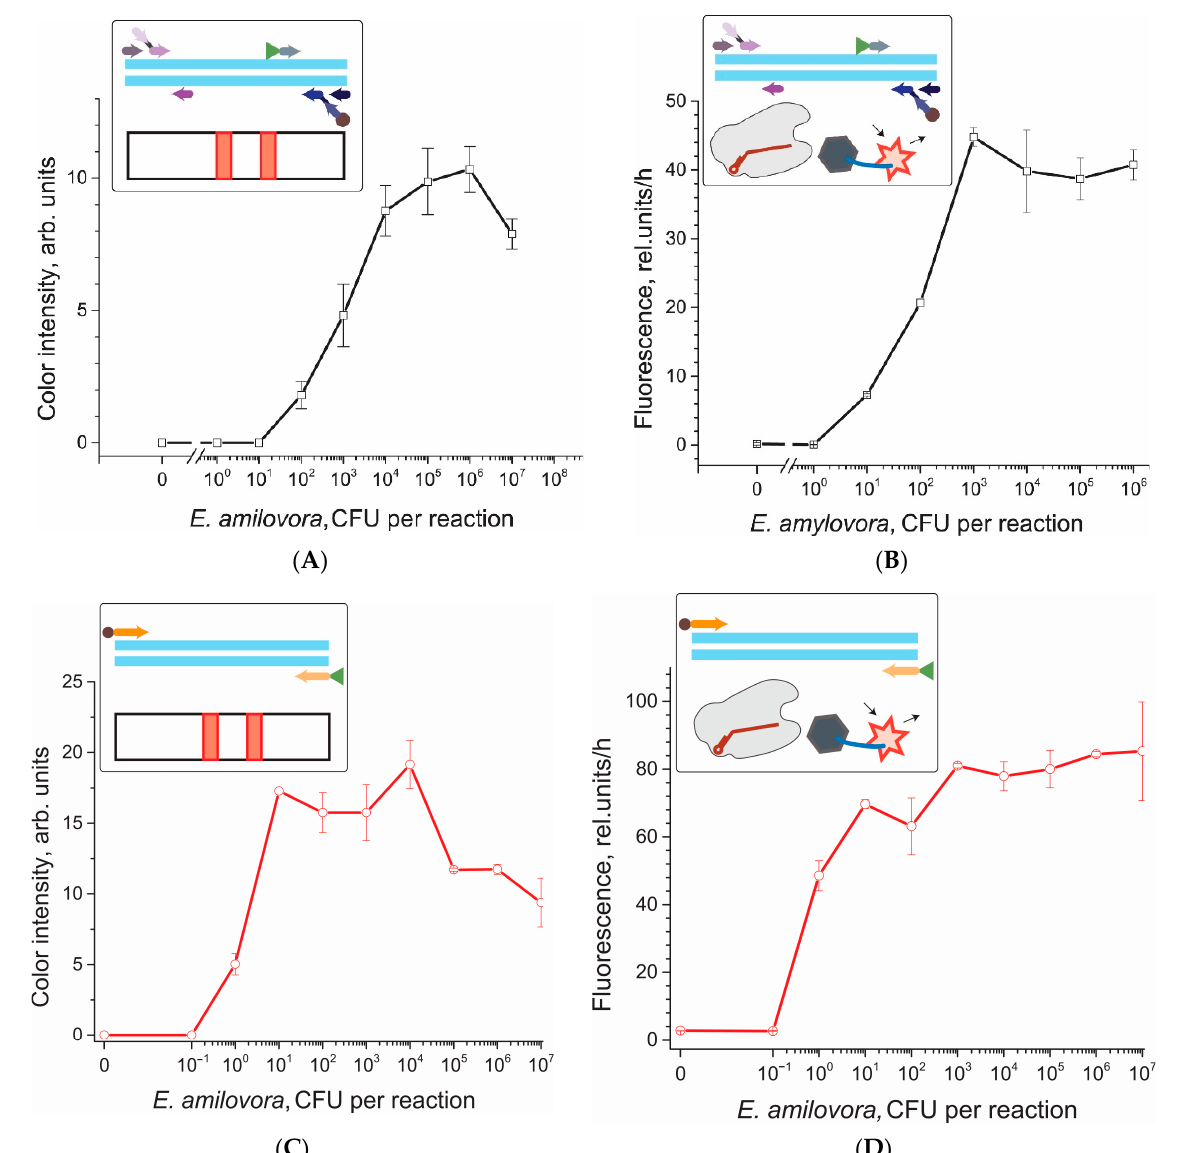
Figure 4. Concentration dependences for E. amylovora cells used for detection by different amplification techniques: ( A ) LAMP-LFT; ( B ) LAMP-CRISPR/Cas; ( C ) RPA-LFT; and ( D ) RPA-CRISPR/Cas.